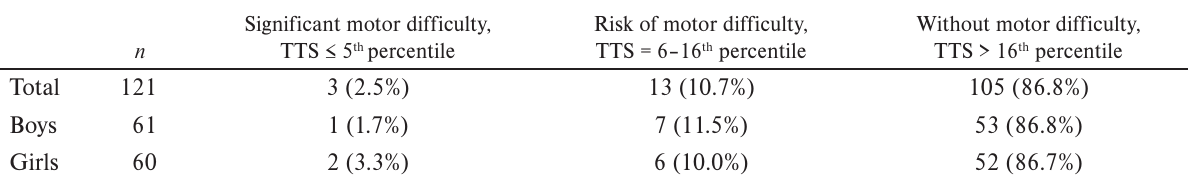
Incidence of motor difficulties based on the total test score (TTS) according to the MABC-2 Age Band 1 test norms Significant motor n